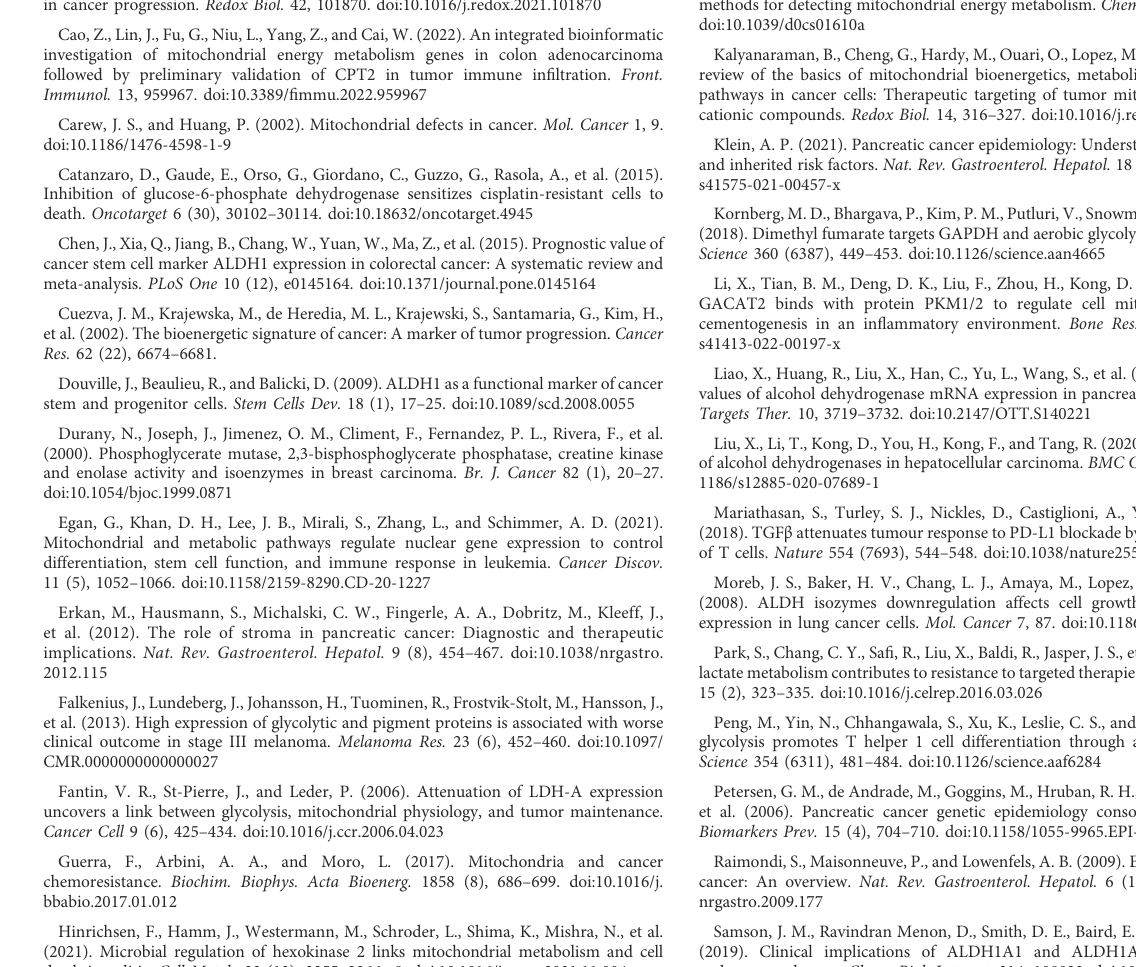
SUPPLEMENTARY FIGURE S1 LASSO regression analysis of 14 potential prognostic factors. The abscissa represents the logarithm of the independent variable Lambda, and the ordinate represents the coef fi cient of the independent variable; (B) LASSO regression con fi dence interval of each lambda; (C) LASSO regression coef fi cient of key prognostic genes. SUPPLEMENTARY FIGURE S2 Prognostic analysis of MMRG core gene signature in validation set. KM, ROC, risk score, survival time distribution, and expression of prognostic factors of MMRG core gene signature. SUPPLEMENTARY FIGURE S3 Performance of the mitochondrial energy metabolism-associated prognostic biomarker in melanoma patients treated with immune checkpoint blockade (GSE91061). KM curve of the high or low-risk groups; (B) Objective response rate in high- and low-risk groups. SUPPLEMENTARY FIGURE S4 Molecular docking results of Lactate dehydrogenase (LDHA) and